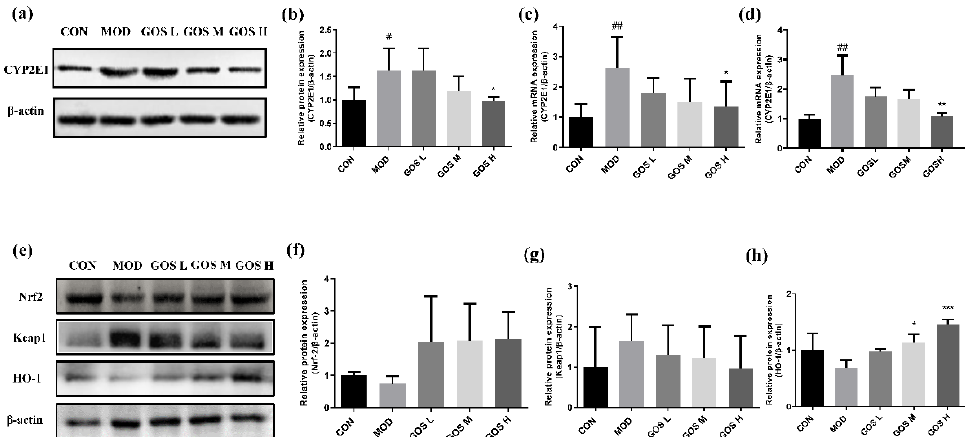
Figure 7. Effects of GOS on the CYP2E1 and Keap1/Nrf2/HO-1 pathway. ( a ) Western blot images of CYP2E1 in mouse liver ( n = 3, means ± SD). ( b ) Protein expression levels of CYP2E1 in mouse liver ( n = 3, means ± SD). ( c ) CYP2E1 mRNA expression in mouse liver ( n = 6, means ± SD). ( d ) CYP2E1 mRNA expression in L02 liver cells ( n = 6, means ± SD). ( e ) Western blot images of the Keap1/Nrf2/HO-1 pathway in mouse liver ( n = 3, means ± SD). ( f ) Protein expression levels of Nrf2 in mouse liver ( n = 3, means ± SD). ( g ) Protein expression levels of Keap1 in mouse liver ( n = 3, means ± SD). ( h ) Protein expression levels of HO-1 in mouse liver ( n = 3, means ± SD). Notes: Compared with the MOD group, * p < 0.05, ** p < 0.01, and *** p < 0.001; compared with the CON group, # p < 0.05, ## p < 0.01.